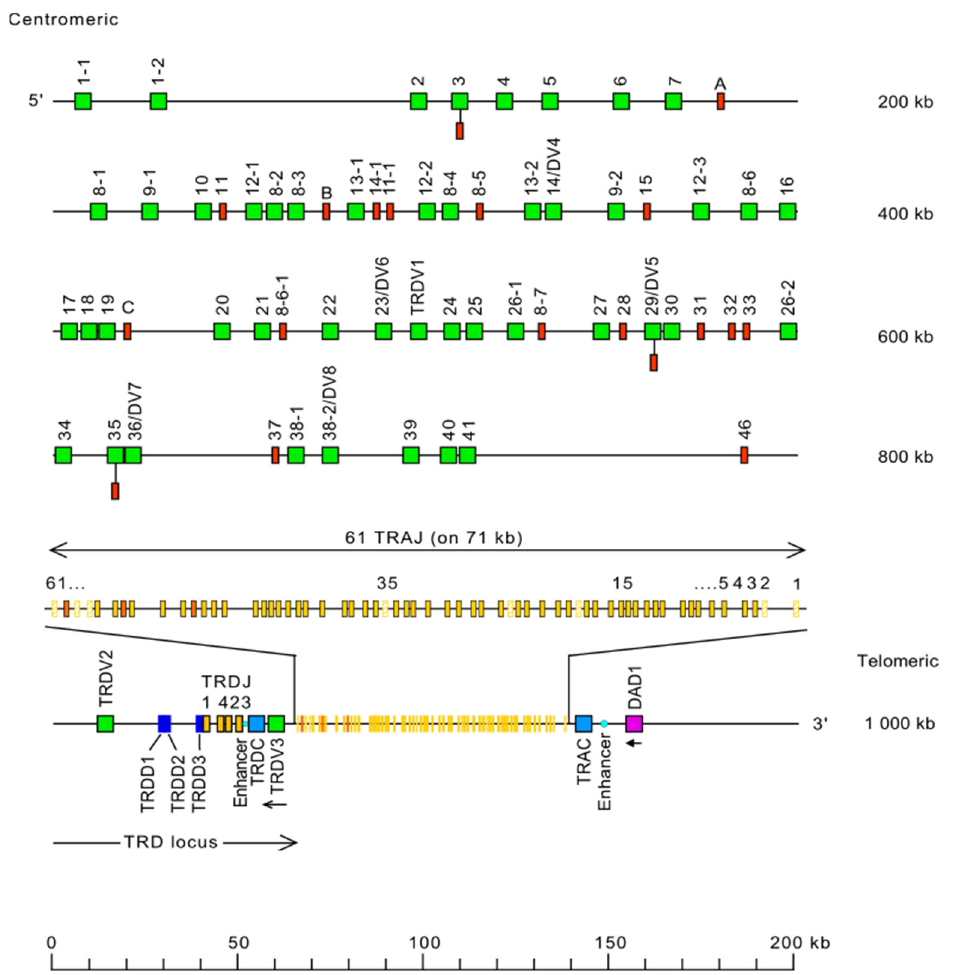
Figure 10. Representation of the human TRA locus at 14q11.2 (FWD orientation on the chromosome) [3]. The boxes representing the genes are not to scale. Exons are not shown. The TRAV genes are designated by a number for the subgroup, followed, whenever there are several genes belonging to the same subgroup, by a hyphen and a number for their relative localization in the locus. Numbers increase from 5 ′ to 3 ′ in the locus. The TRD genes are nestled in the TRA locus [3]. IMGT ®